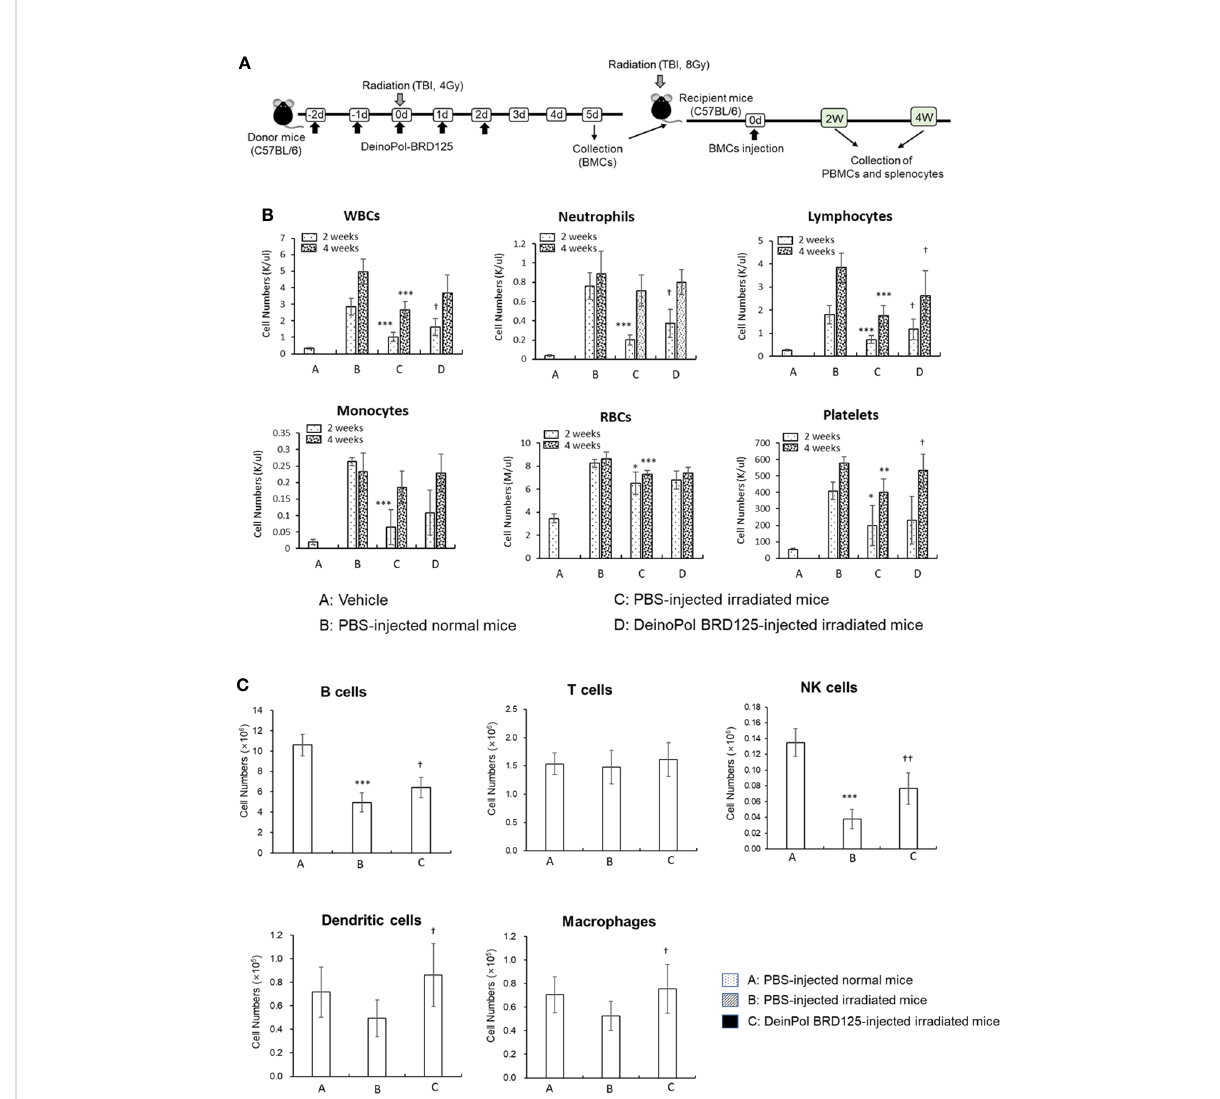
FIGURE 6 DeinPol-BRD125 enhances multilineage engraftment of irradiated hematopoietic stem cells after BM transplantation. (A – C) Mice were injected intraperitoneally with DeinoPol-BRD125 (50 mg/kgBW) two times before and three time after irradiation at a dose of 4 Gy. At 7 days after irradiation, bone marrow (BM) cells were injected into the tail veins of recipient mice previously administered lethal irradiation. Schematic schedule of BM transplantation experiment (A) . Cells in peripheral blood at 2 and 4 weeks after BM transplantation were counted by automatic blood analyzer (B) . Cell populations in the spleen at 2 weeks after BM transplantation were was analyzed by fl ow cytometry (C) . *p<0.05, **p<0.01, and **p<0.001 compared to recipient mice transplanted with PBS-injected normal mice. † p<0.05 and †† p<0.01 compared to recipient mice transplanted with BM cells from PBS-injected irradiated